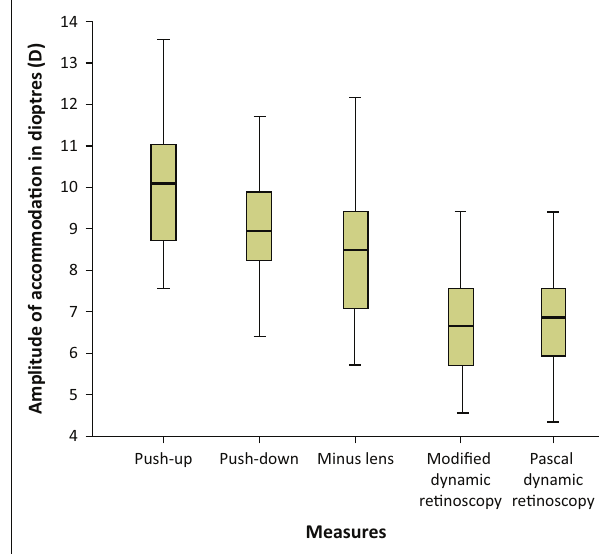
FIGURE 1: Box plots of the different measures of the amplitude of accommodation. The box plots display the distributions of the amplitude of accommodation measurements based on the minima, first quartile, second quartile, third quartile and the maxima per sample. Horizontal bold lines inside the boxes show the medians, and whiskers above and below the boxes show the location of the minima and maxima. The interquartile range (IQR) spans the first and third